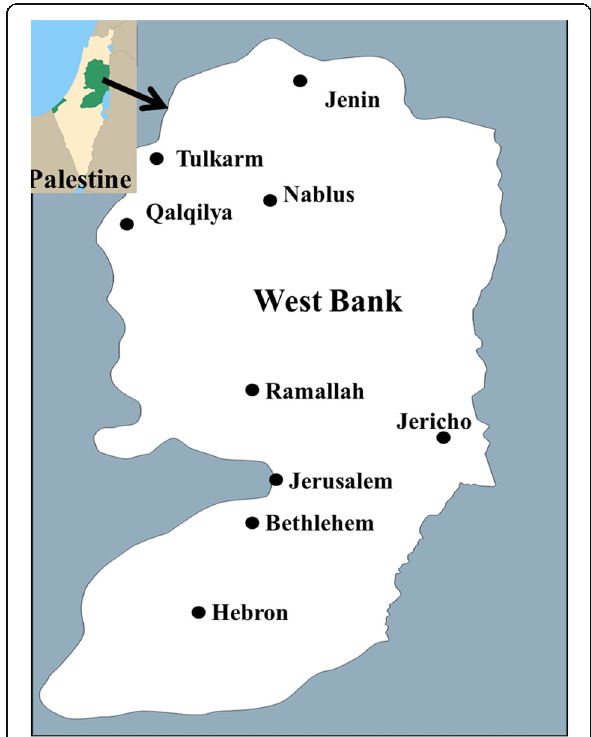
Fig. 1 Map of the West Bank/Palestine showing all surveyed